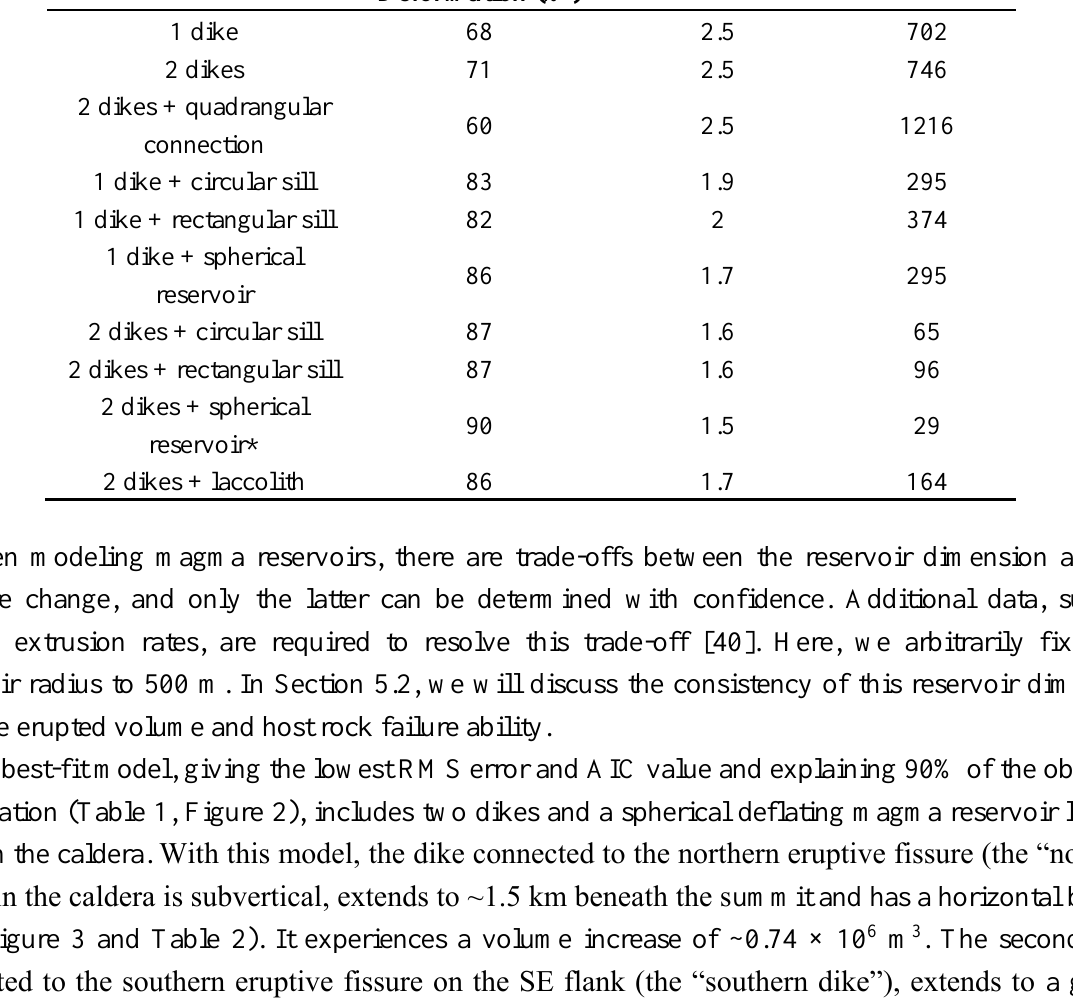
Table 1. Comparison of the best-fit model obtained for each combination of sources inverted. Note that several inversions were run for each possible source combination; only the best-fit result obtained for each combination is shown. * denotes the preferred model among all of the best-fit models. Percentage of explained deformation and RMS error are defined in the Supplementary Materials. Explained Model RMS Error Deformation (%)